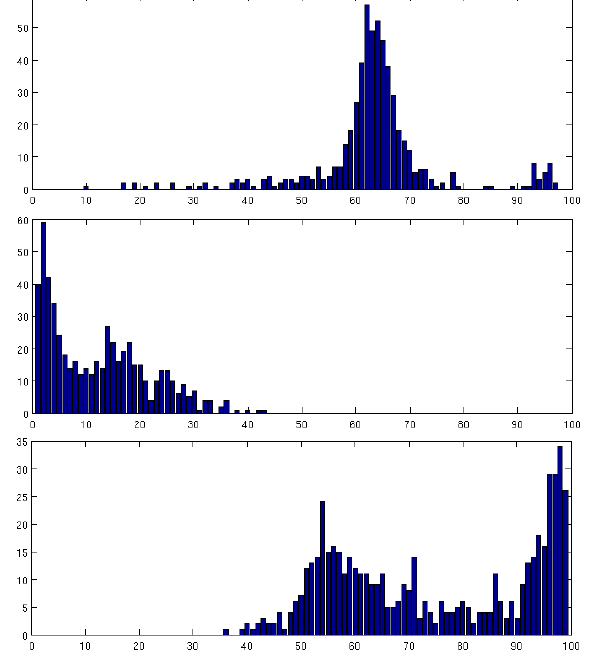
Figure 6: Histograms of the CCH mean values from 557 cars in the HSV color space. From top to bottom: H, S, V.